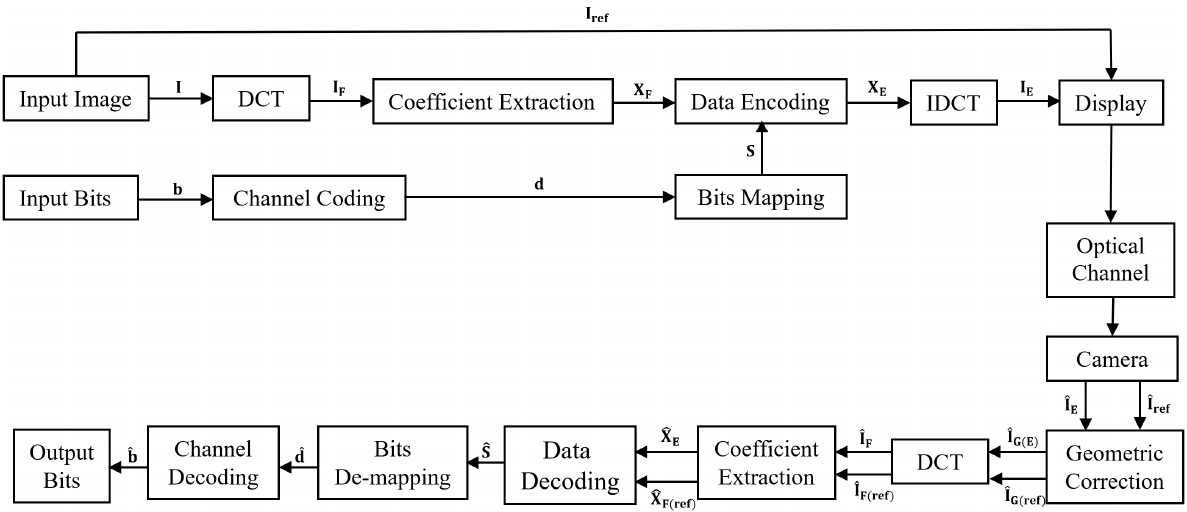
Figure 1. Schematic of the network architecture of the proposed D2C system.